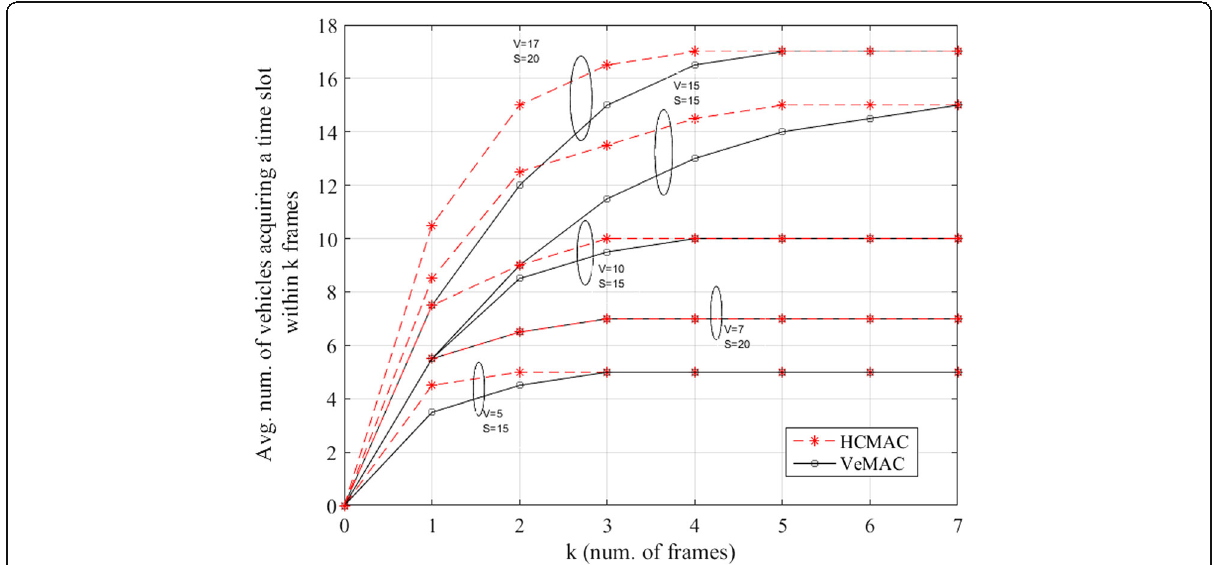
Fig. 15 Avg. number of vehicles acquiring a time slot within k frames (analytical results, W =